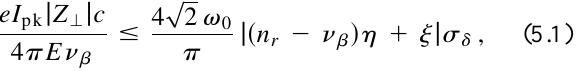
(cid:2) E and therefore